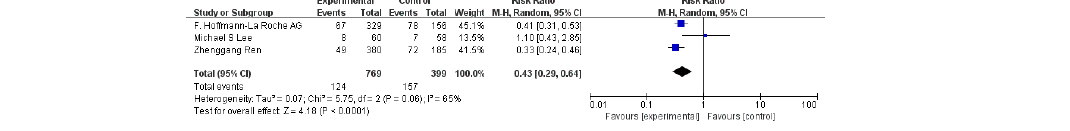
FIGURE 9 Forest plot of the incidence of diarrhea (grade 1-2) in patients with HCC treated with ICIs and antiangiogenic drugs in combination or